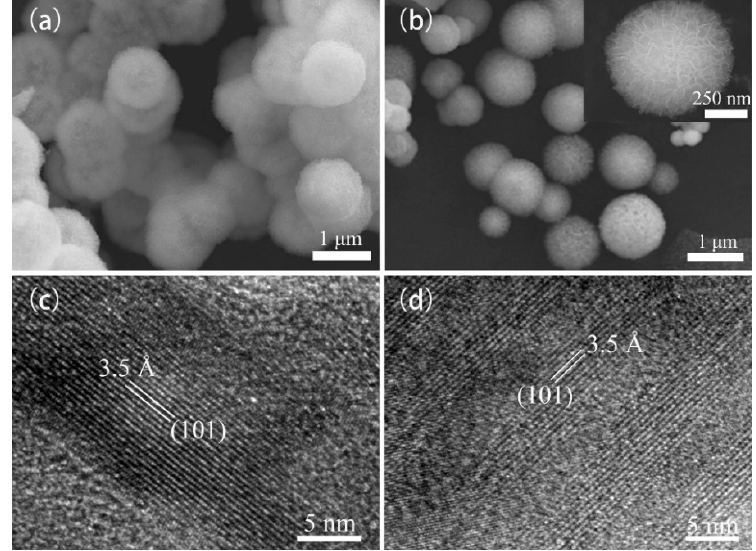
Figure 1. SEM images ( a and b ) and HRTEM (c and d) images of TiO 2 nanospheres before ( a and c ) and after ( b and d ) Aphen modifying. Inset: SEM images of single Aphen modified TiO 2 ( b , d ) Aphen modifying. Inset: SEM images of single Aphen modified TiO 2 nanocrystals. nanocrystals.